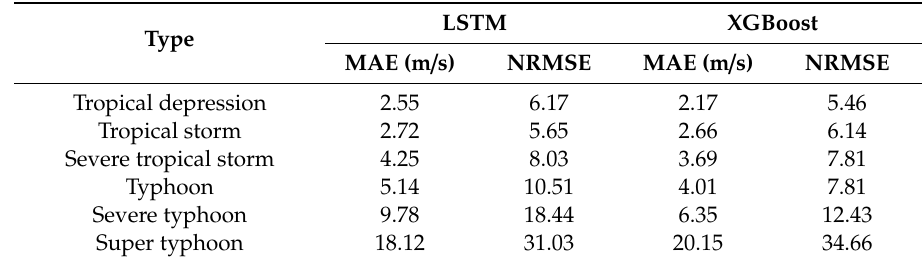
Table 10. LSTM and XGBoost model errors for di ff erent tropical cyclone intensity levels at a 12 h lead time. LSTM XGBoost Type MAE (m / s) NRMSE MAE (m / s) NRMSE